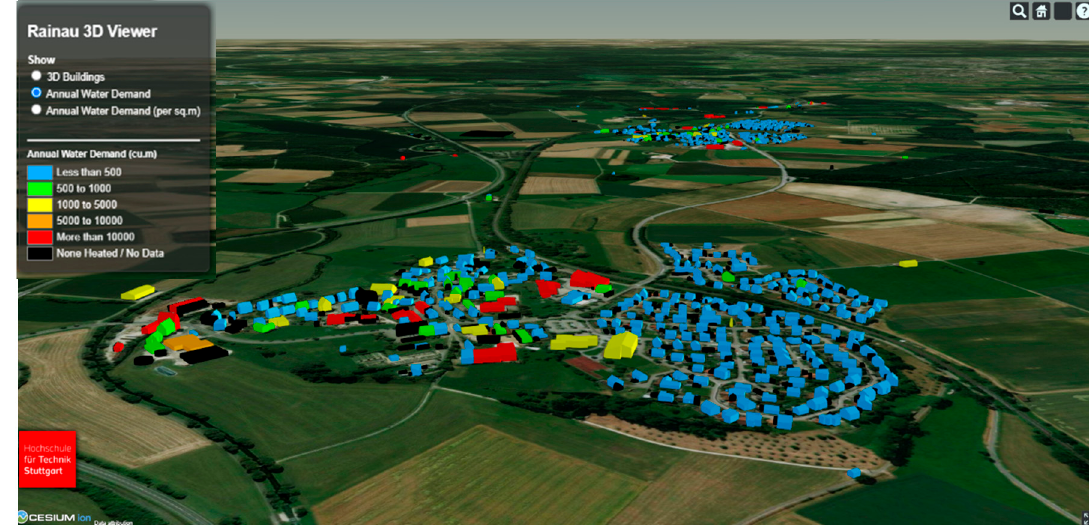
Figure 6. Visualization of water demand per building in m 3 in Rainau with CityGML and satellite map. Figure 7 does not give the total water demand, but water demand per floor area. Residential